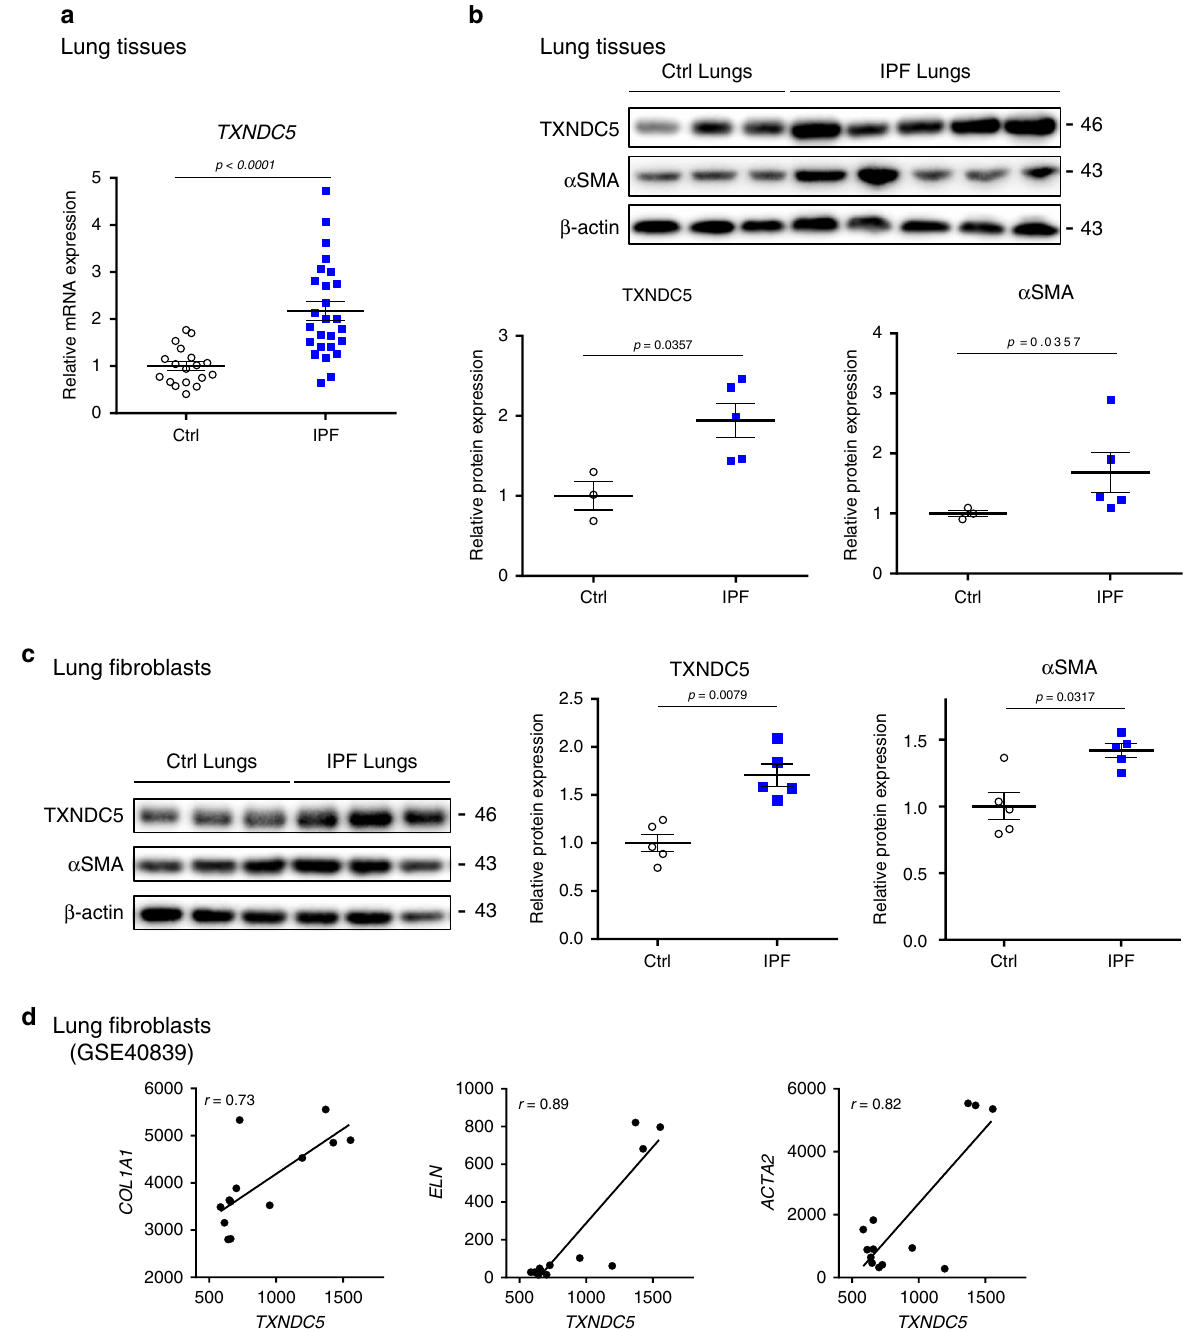
Fig. 1 TXNDC5 was upregulated in IPF lungs/lung fi broblasts and correlated with fi brogenic genes. a Transcript analysis showed signi fi cant upregulation of TXNDC5 mRNA in human IPF ( n = 26, central and lateral lung from 13 biologically independent samples), compared with control ( n = 18, central and lateral lung from 9 biologically independent samples), lung tissues. b Immunoblot analysis showed a marked increase in TXNDC5 and α SMA protein levels in human IPF ( n = 5 biologically independent samples), compared with control ( n = 3 biologically independent samples), lung tissues. c Protein expression level of TXNDC5 and α SMA were also increased in IPF, compared with control, lung fi broblasts following TGF β 1 treatment ( n = 5 biologically independent samples per group). d Re-analyses of microarray data from IPF human lung fi broblasts (GSE40839) 15 revealed strong positive correlation between the expression level of TXNDC5 and that of genes encoding fi brogenic proteins ( COL1A1, ELN, ACTA2 ) in human lung fi broblasts (n = 13 biologically independent samples per group) (Data are presented as mean ± SEM, P value determined using two-tailed Mann – Whitney U test. Source data are provided as a Source Data fi fi brotic foci with strong staining of α SMA in BLM-treated mouse Fn , Ctgf , as well as Txndc5 , were signi fi cantly upregulated in BLM- treated mouse lungs (21 days post-BLM treatment, Fig. 2a). In lungs (Fig. 2b, inset). IHC staining in serial sections of fi brotic addition, immunohistochemical (IHC) staining revealed distorted mouse lungs also detected marked increases in TXNDC5 staining, alveolar structure, thickened alveolar walls, and formation of particularly in the α SMA-positive fi brotic foci (Fig. 2b, inset).